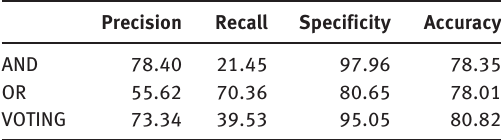
Table 3. Accuracy Results for AND, OR, and VOTING on the UCD Database. Precision